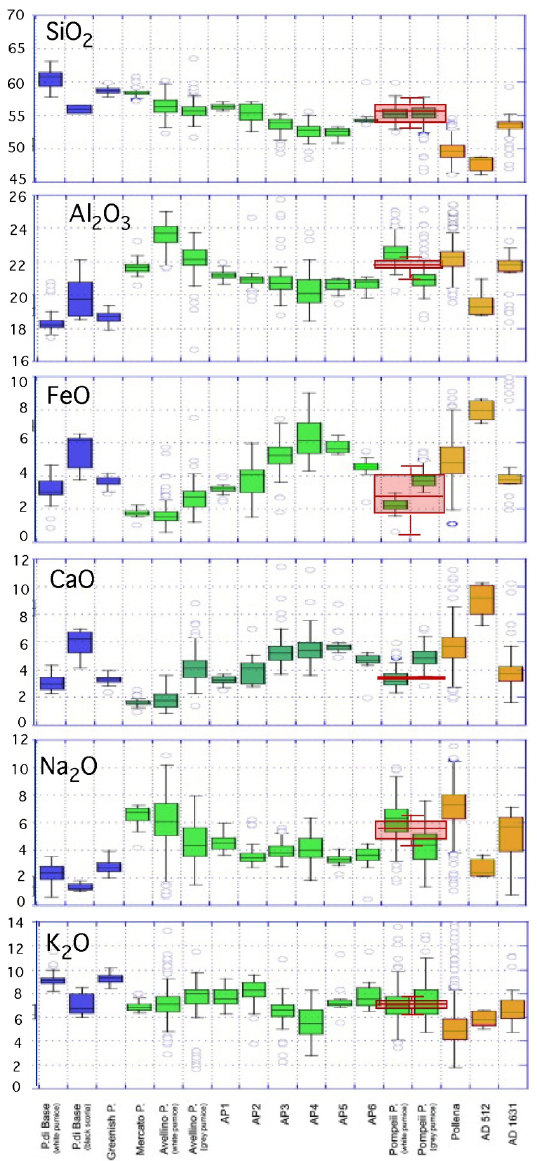
Fig. 6. Box and whiskers plots representing analyses of this work (red) compared with the range of EDS glass analyses of Vesu- vius tephra (Santacroce et al., 2008). AP1 to AP6 signify ex- plosive activity occurring between the larger Avellino and Pom- peii eruptions (Santacroce et al., 2008 and references within). The box and whiskers diagrams outline the median values (mid- dle line), the middle two quartiles (shaded boxes), outer quar- tiles (whiskers), and outlying values (circles). The orange boxes demonstrate the strongly SiO 2 -undersaturated glasses younger than 79AD, the green boxes represent the mildy SiO 2 -undersaturated glasses from 8900B.P. to 79AD, while the blue boxes mark the composition of the slightly SiO 2 -undersaturated glasses older than 8900BP as defined by Santacroce et al.